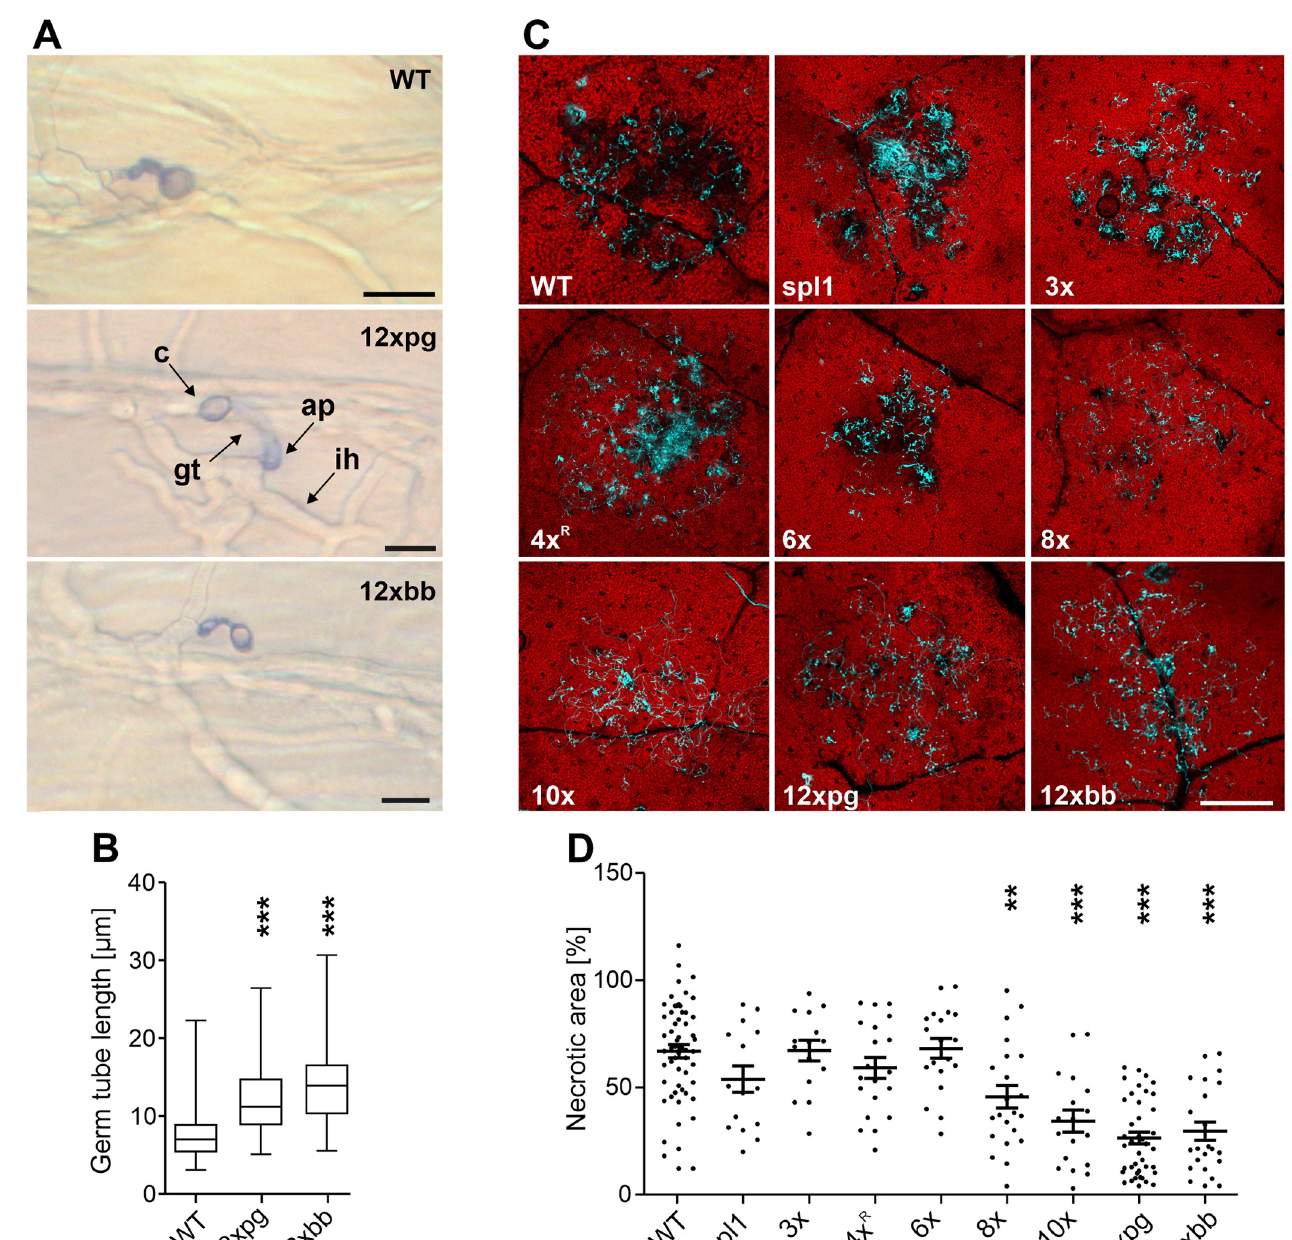
Fig 4. Microscopic analysis of penetration and host necrosis induction by B . cinerea WT and mutants. A: Penetration of onion epidermis cells by germinated conidia of WT, 12xpg and 12xbb mutants. Superfical structures, namely conidium (c), germ tube (gt) and appressorium (ap) are stained with trypan blue, whereas intracellular hyphae (ih) remain unstained. Scale bars: 10 μ m. B: Quantification of germ tube length of germinated and penetrated conidia. One-way ANOVA and Dunnett´s post hoc test (control: WT). ��� p value < 0.001. C: Induction of host cell necrosis by B . cinerea on detached Phaseolus leaves (24 h.p.i.). Fungal hyphae were stained with calcofluor white, host cell death is visible by loss of red autofluorescence. Scale bars: 500 μ m. D: Mean extent of host necrosis under the inoculation site. One-way ANOVA and Dunnett´s post hoc test (control: WT). �� p < 0.01; ��� p < 0.001. intensities of the detected secreted proteins between independent samples, compensatory changes were difficult to determine. Analysis of the proteome data using the Perseus bioinfor- matic platform [46] did not reveal evidences for differential protein abundance in WT and mutant secretomes.